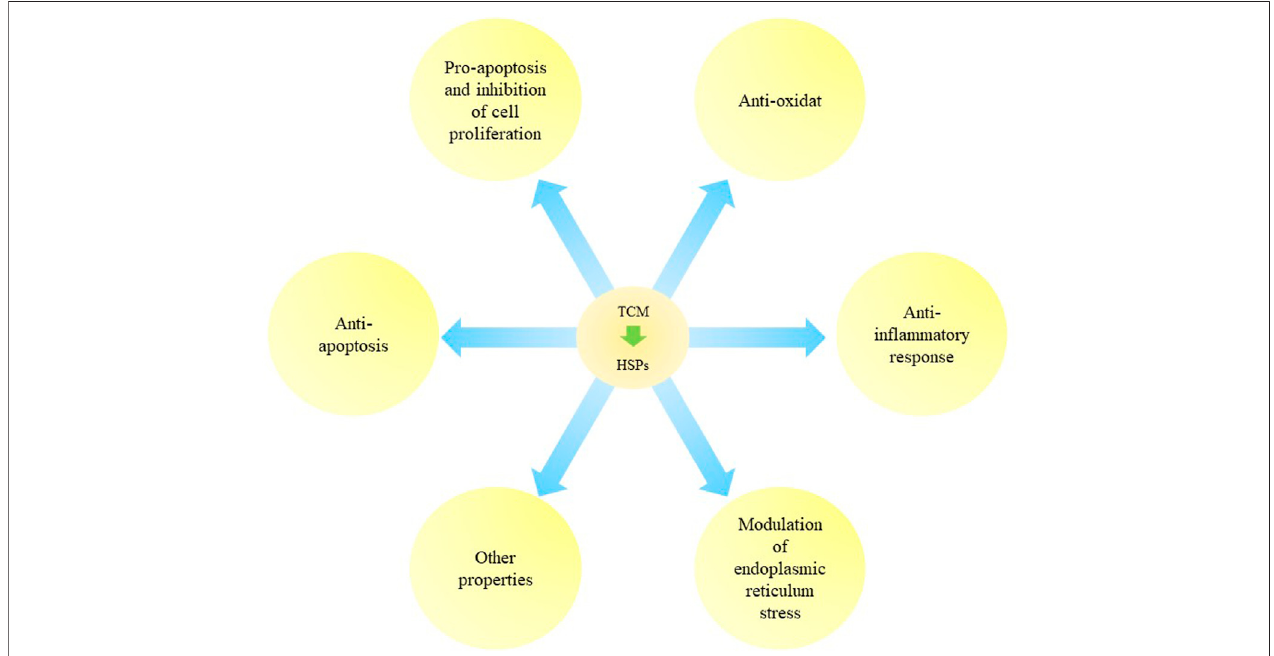
FIGURE 2 | The regulation of Traditional Chinese Medicine on heat shock proteins. Traditional Chinese medicine (TCM) can exert various biological functions like anti-apoptosis, pro-apoptosis and inhibition of cell proliferation, anti-oxidant, anti-in fl ammatory response, modulation of ER stress and other properties via regulating HSPs.